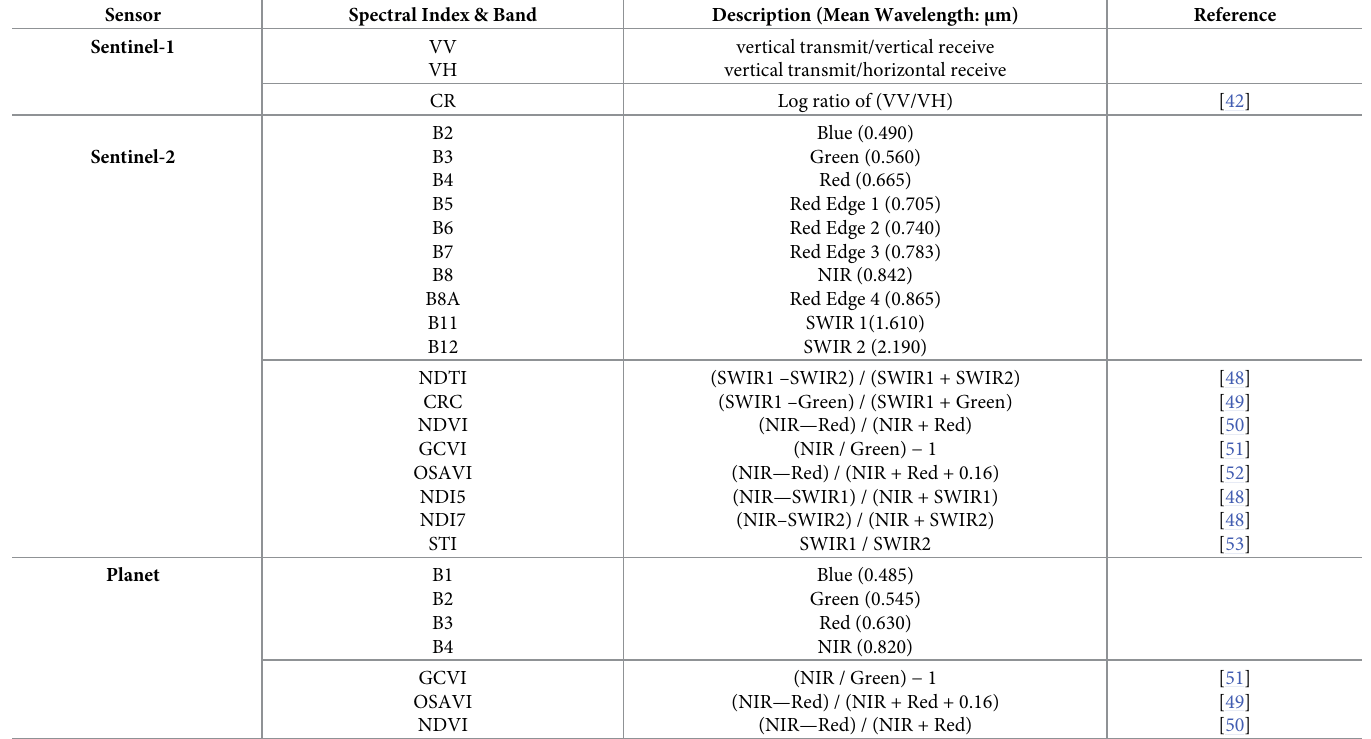
Table 2. Band and index information for the three sensors used in this